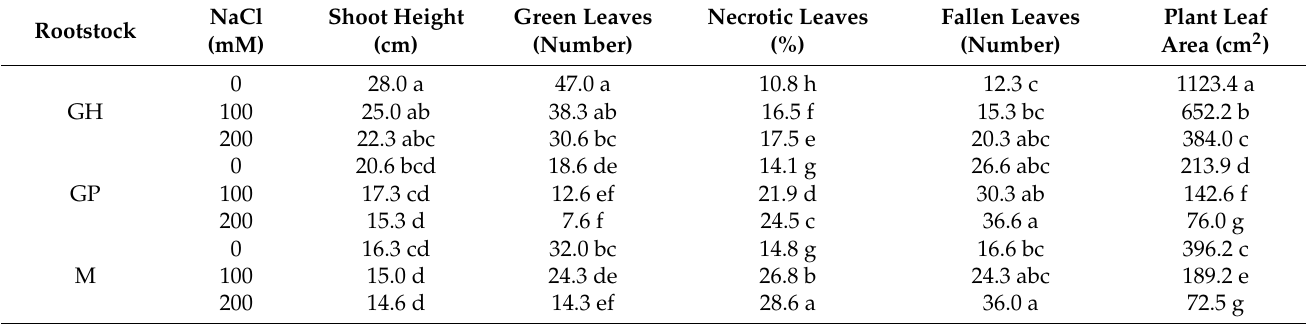
Table 1. Effects of salinity on growth of three pistachio rootstocks, including GH (Ghazvini), GP (Ghermez-Pesteh) and M ( P. atlantica subsp. mutica ).